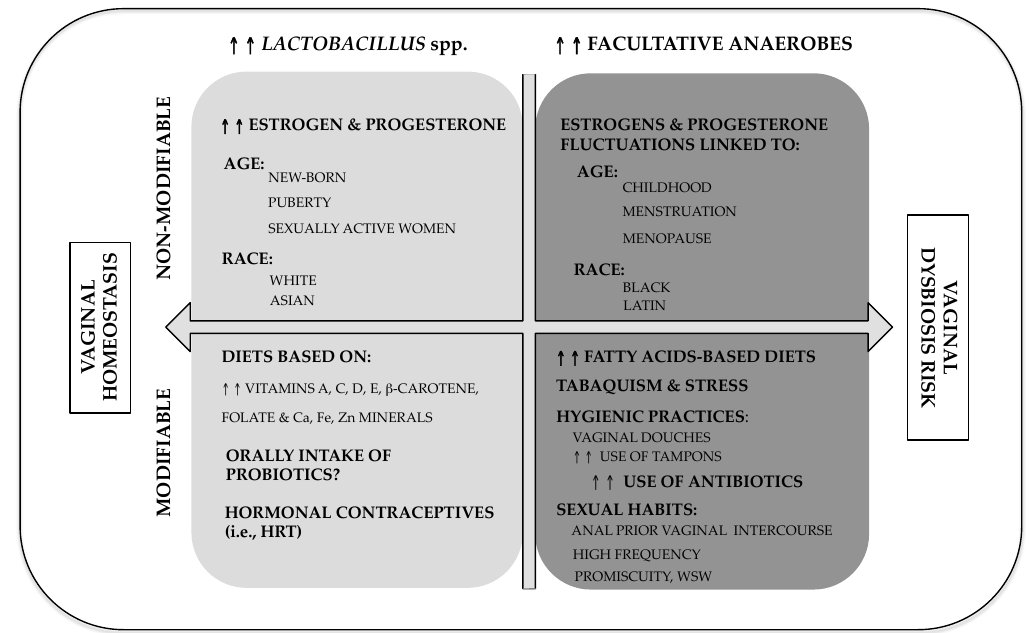
Figure 1. Modifiable and non-modifiable risk factors associated with vaginal homeostasis and dysbiosis. Inherent human conditions linked to vaginal homeostasis and associated with vaginal dysbiosis risk are depicted in the top part of the panel, while modifiable factors are shown in the bottom part. Top and bottom left sections -­‐‑defined by a double pointed arrow-­‐‑ report those factors that contribute positively to homeostasis. Conversely, right top & bottom sections report those factors associated to vaginal dysbiosis risk. Both of them are associated with a microbiota rich in diverse facultative anaerobes microorganism opposite to those rich in Lactobacillus spp. (left sections).